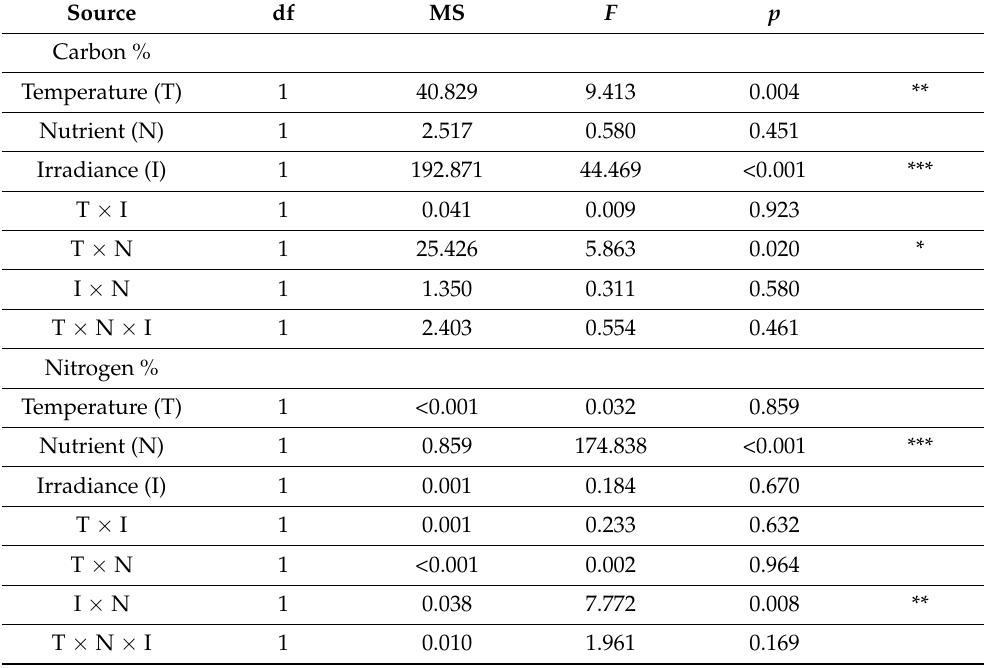
Table 3. Results of three-way ANOVA on the effects of temperature, nutrient availability, and irradiance on biochemical composition of Sargassum fusiforme . Sources that are significant at p < 0.05, p < 0.01 and p < 0.001 are denoted as ‘*’, ‘**’ and ‘***’